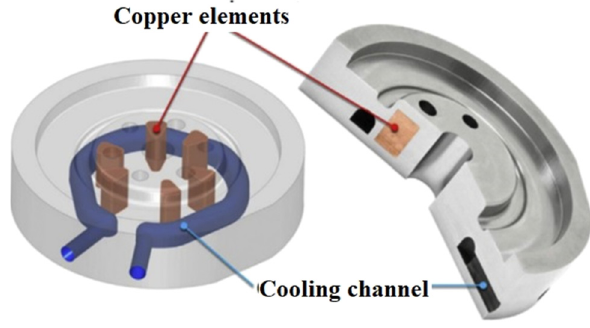
Figure 12: AM with copper and tool steel with cooling channel - drawing [ 1 ] .